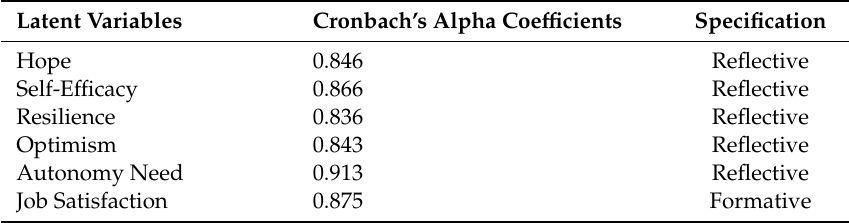
Table 8. Construct reliability